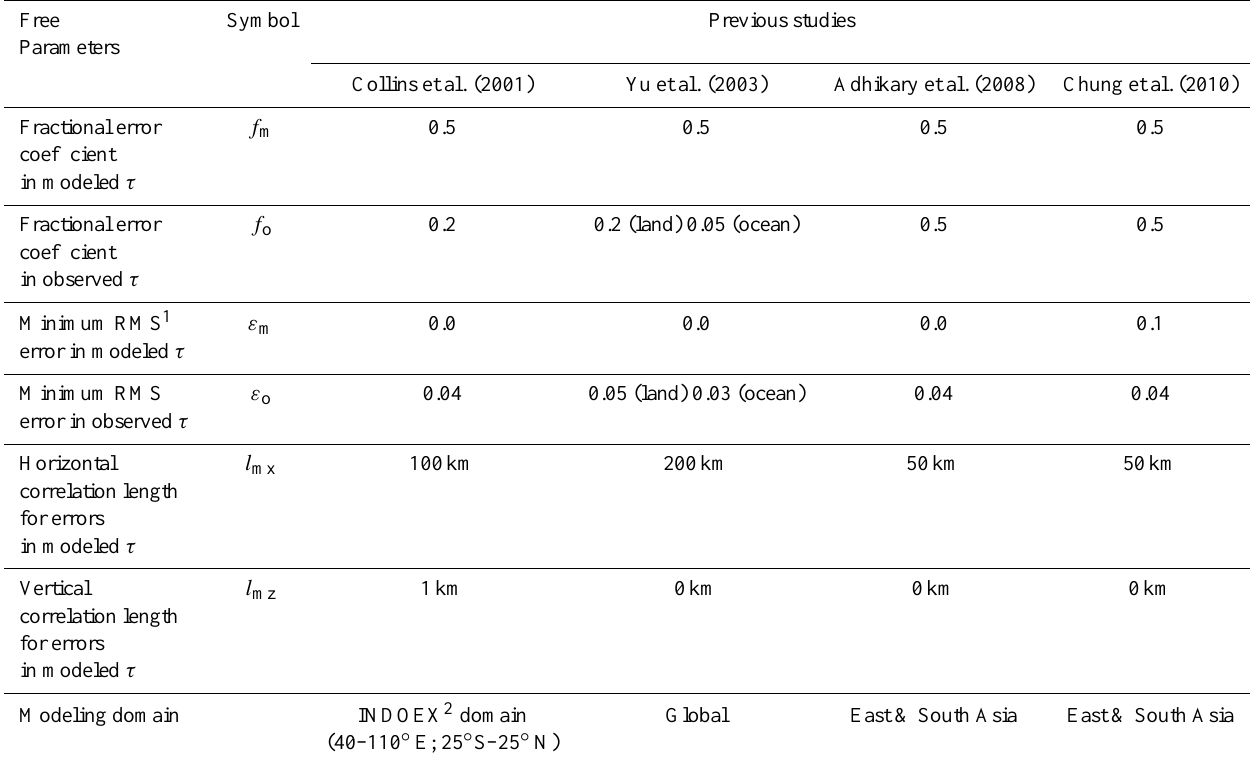
Table 5. Free parameters of the data assimilation and the modeling domains used in the previous studies.